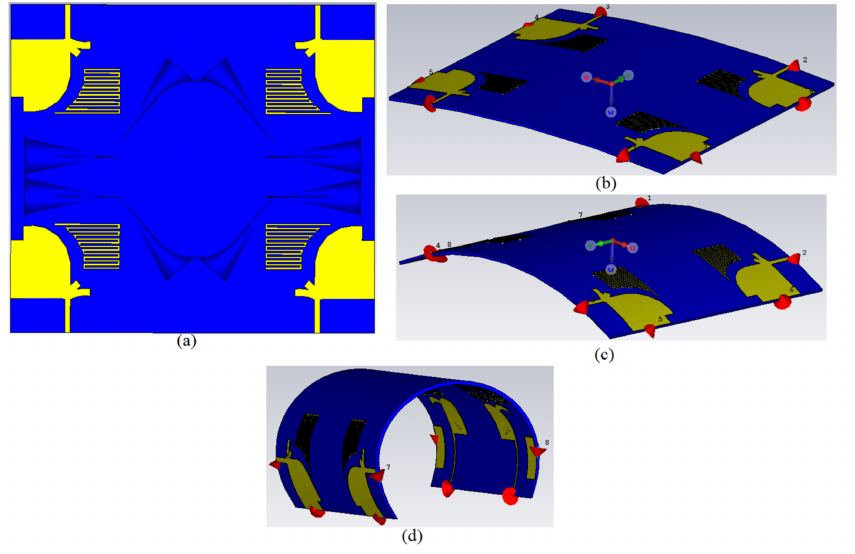
Figure 24. Flexibility investigation of the proposed 8 ports MIMO ( a ): creased substrate, ( b ): 10 degrees, ( c ): 50 degrees, ( d ): 190 degrees.